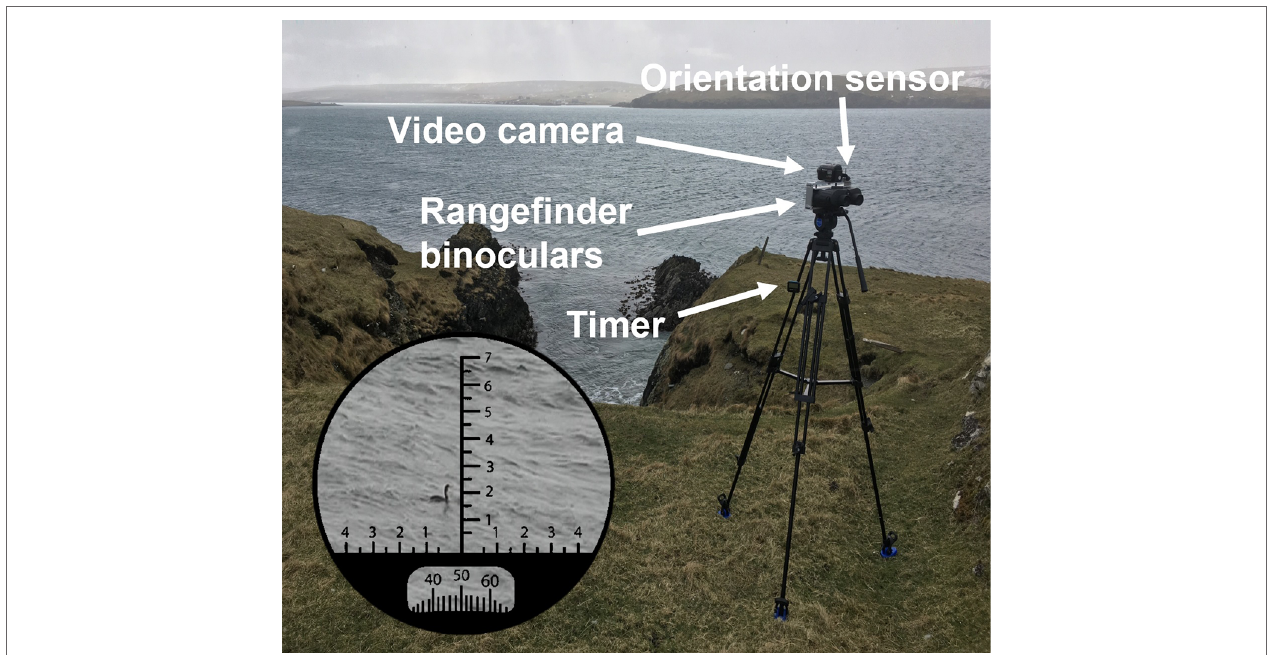
FIGURE 2 | Photograph of the in-situ combination of rangefinder binoculars, camcorder, orientation sensor and digital timer used to record the locations and behavior of foraging animals in study sites. Also illustrated is the view through the eyepiece showing the reticles used to ensure that the animal was in the center of the eyepiece, maximizing the accuracy of distances to the animal calculated from the orientation sensor, and the compass used to measure the bearing (°) to the